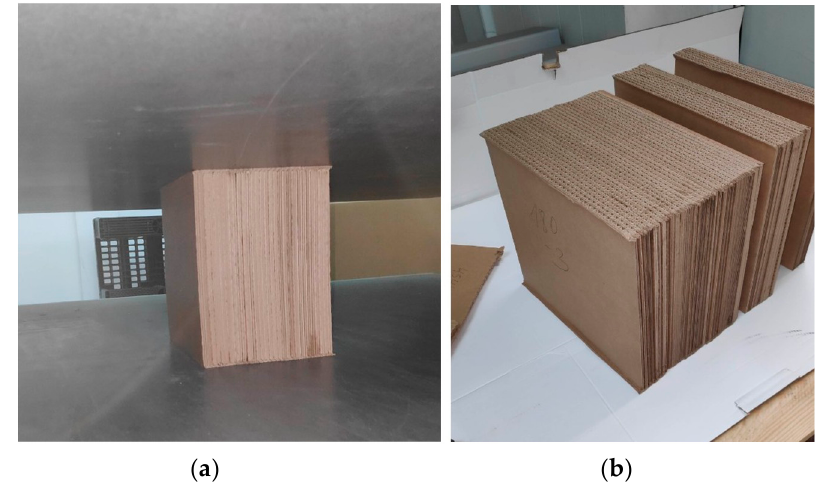
Figure 3. Block testing: ( a ) Inside the test machine; ( b ) After the test. Table 2. Data for the tested cardboard blocks.